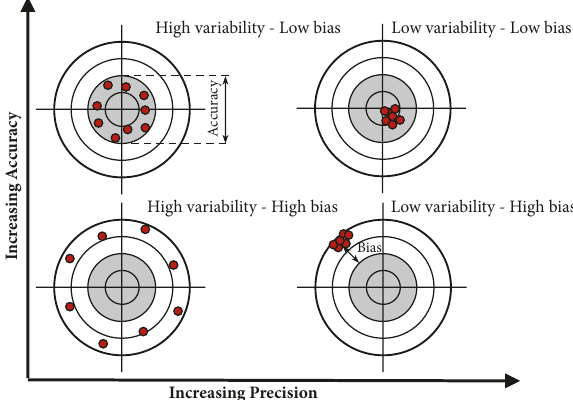
Figure 2: The relationship between precision and accuracy.